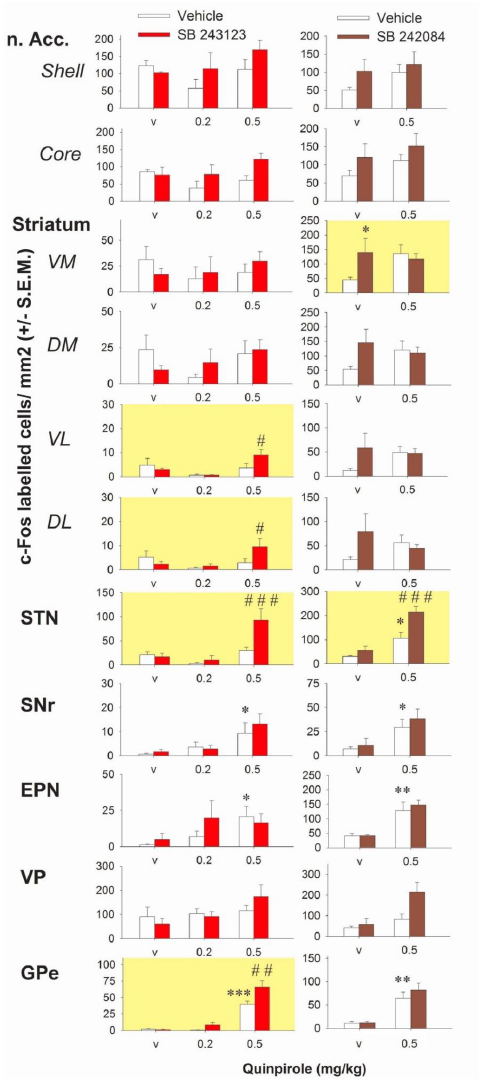
Figure 2. Effect of 5-HT 2C antagonism on the number of c-Fos immunolabeled cells by quinpirole in the basal ganglia. The left column corresponds to the interaction of SB 243213 (1 mg/kg i.p.) with quinpirole (Quinp, 0.2 and 0.5 mg/kg, i.p.). The right column corresponds to the interaction of SB